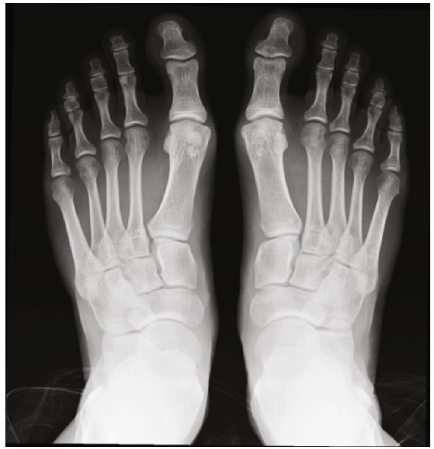
Figure 1: X-ray of the right and left feet demonstrating bilateral bipartite sesamoid bone and absence of other